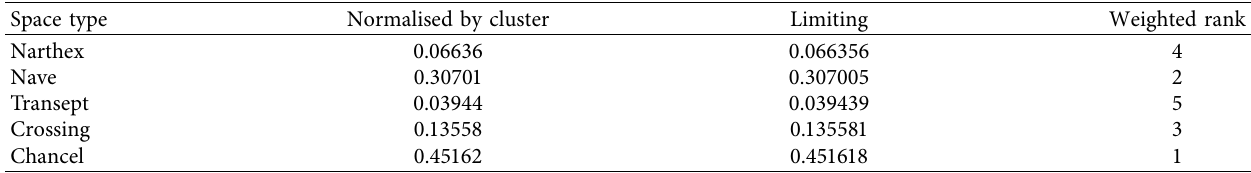
Table 7: Te priorities of each space type inside a